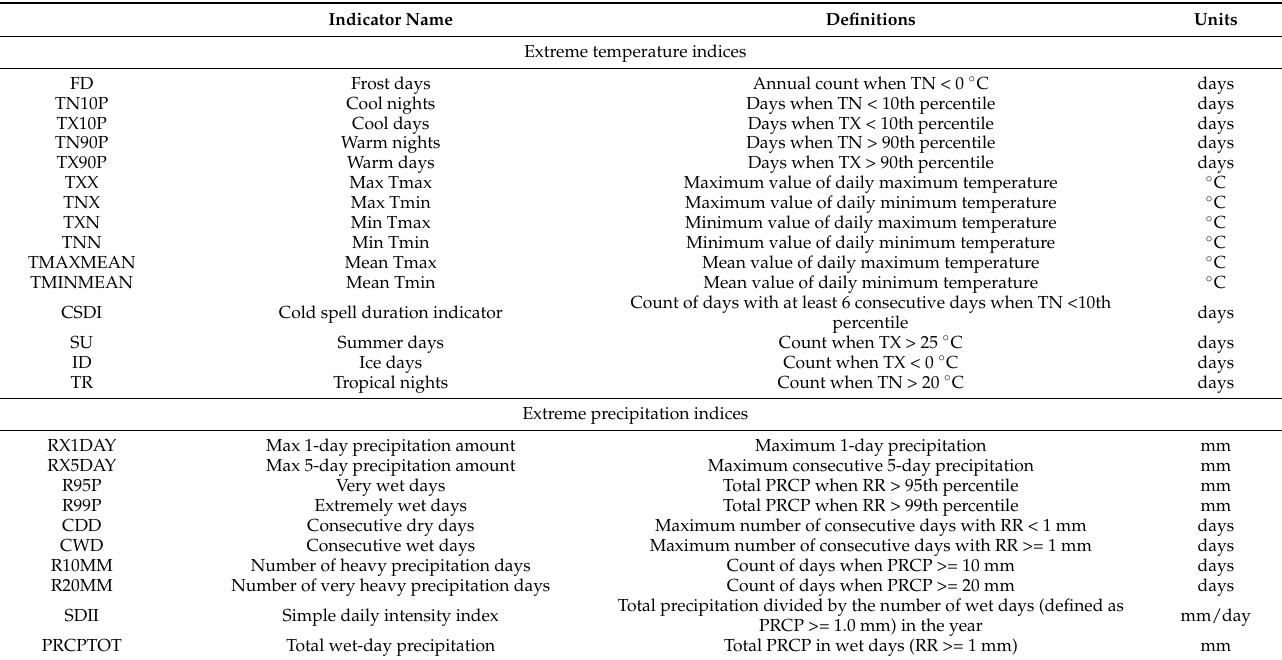
Table 1. Definition of climate extreme indices used in this study. TN, daily minimum temperature; TX, daily maximum temperature; RR, daily